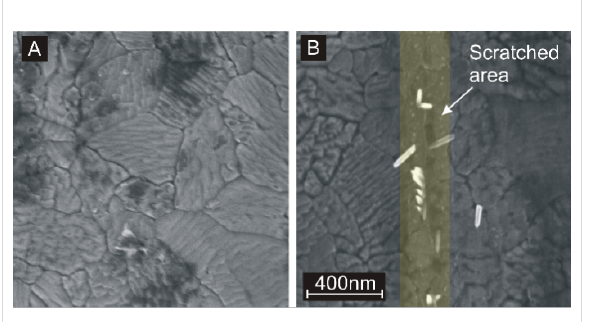
Figure 5: SEM images of a sample where the anatase layer is covered with a 3 nm thin SiO 2 layer. The scratched area is shown before (panel A) and after (panel B) the hydrothermal growth process. The density of nanorods is much less compared to Figure 4. The yellow area marks roughly the region where the AFM tip scratched the